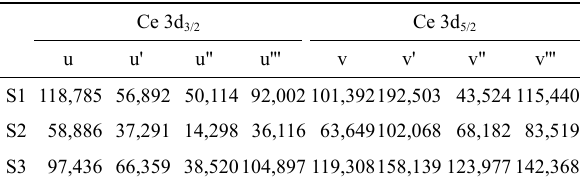
Table 2 Concentrations of Ce 3+ and Ce 4+ ions and stoichiometry ratios of CeO 2 nanowires annealed under different controlled conditions Concentration Stoichiometry ratio Ce 3+